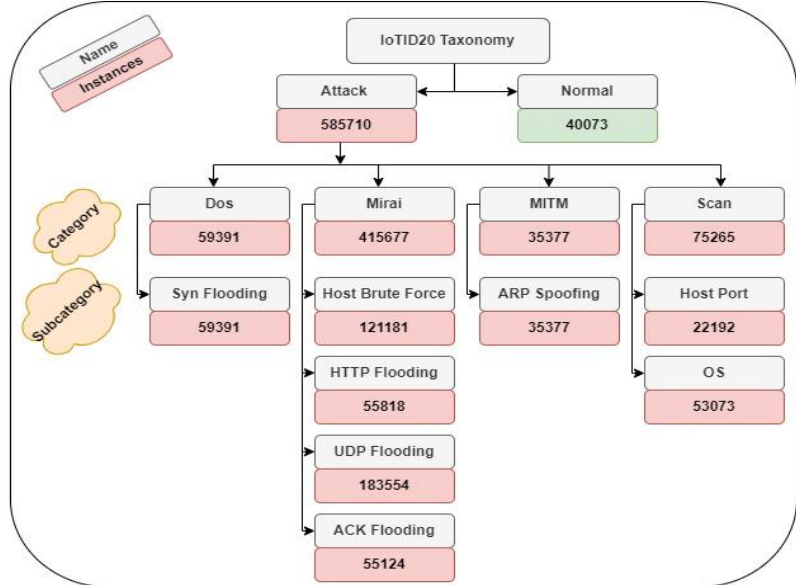
Figure 3. IoTID20 dataset taxonomy.